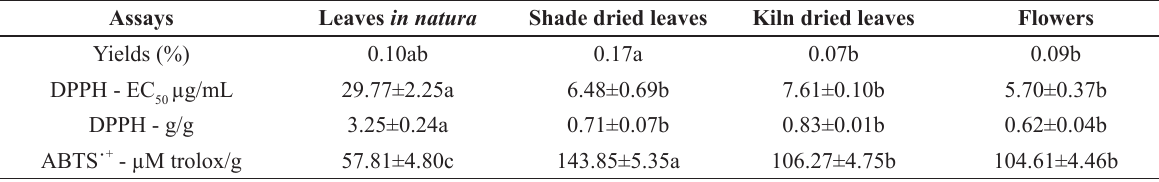
Values represent the mean ± standard deviation of three samples. Means followed by equal letters in the same line do not differ among each other, by the Tukey’s test (p >